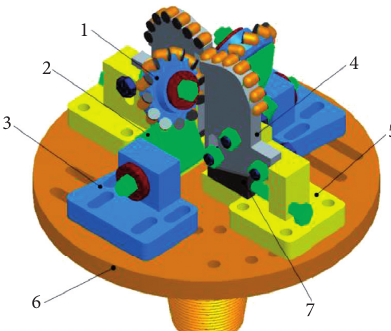
Figure 17: 3D model of the experiment bit.